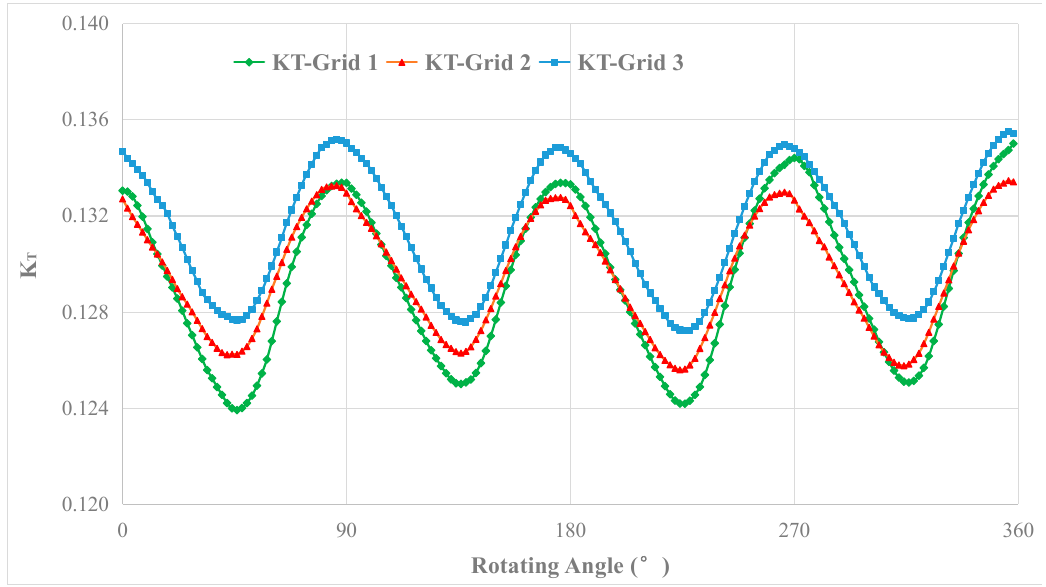
Figure 6. The variation of the thrust coefficient K T over the last full propeller revolution.